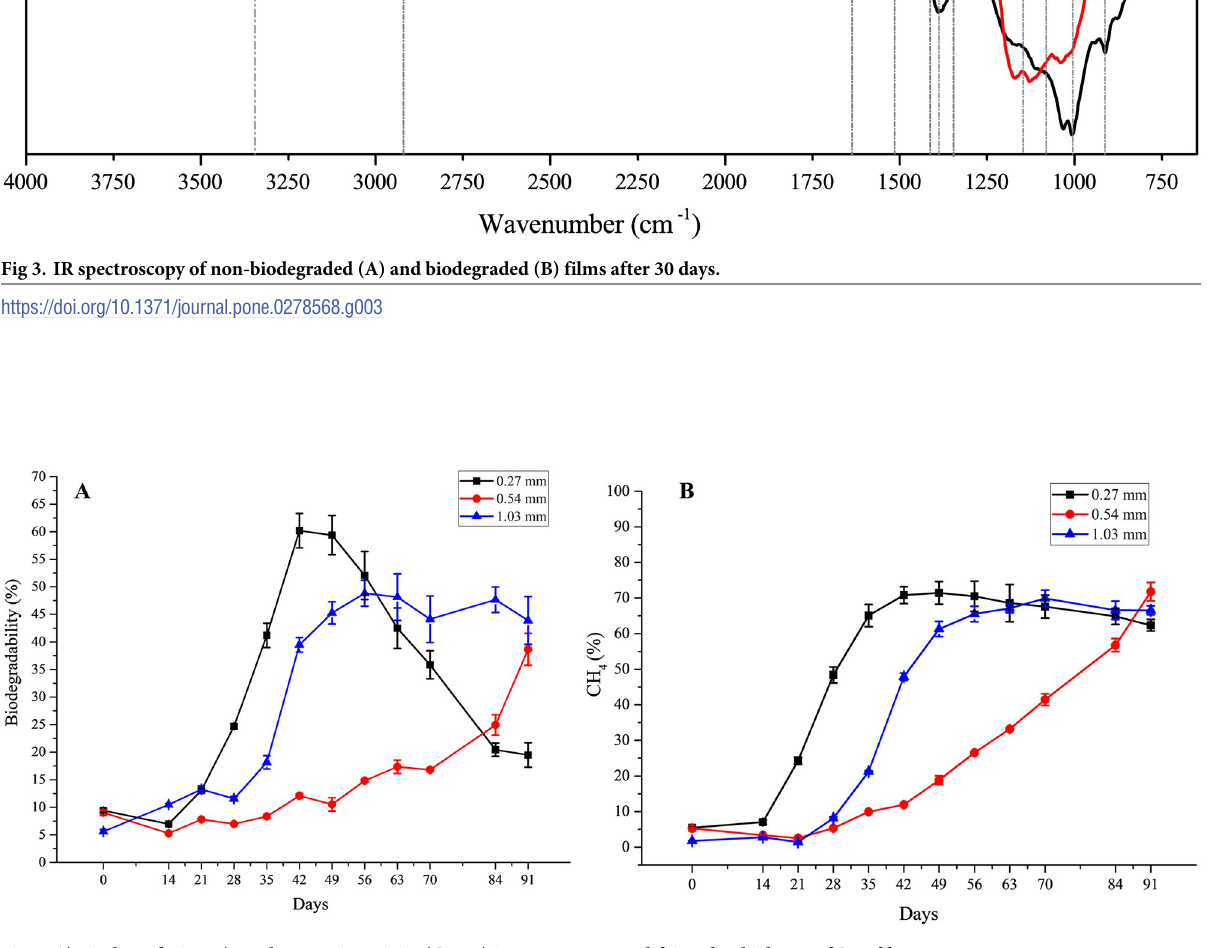
Fig 4. A) Biodegradation B) Methanogenic activity (CH 4 %) in response to modifying the thickness of SRF films.